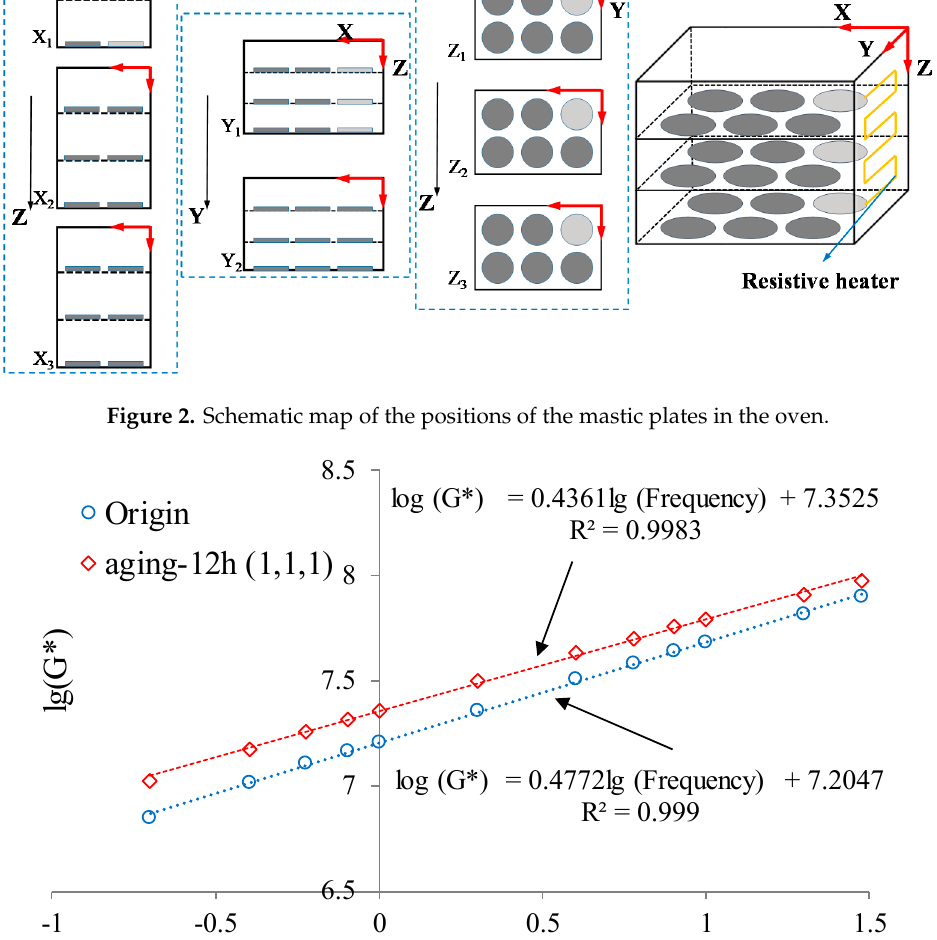
Table 3. Parameter G* of the mastics at different positions and sensitivity analysis of different positions to G*.